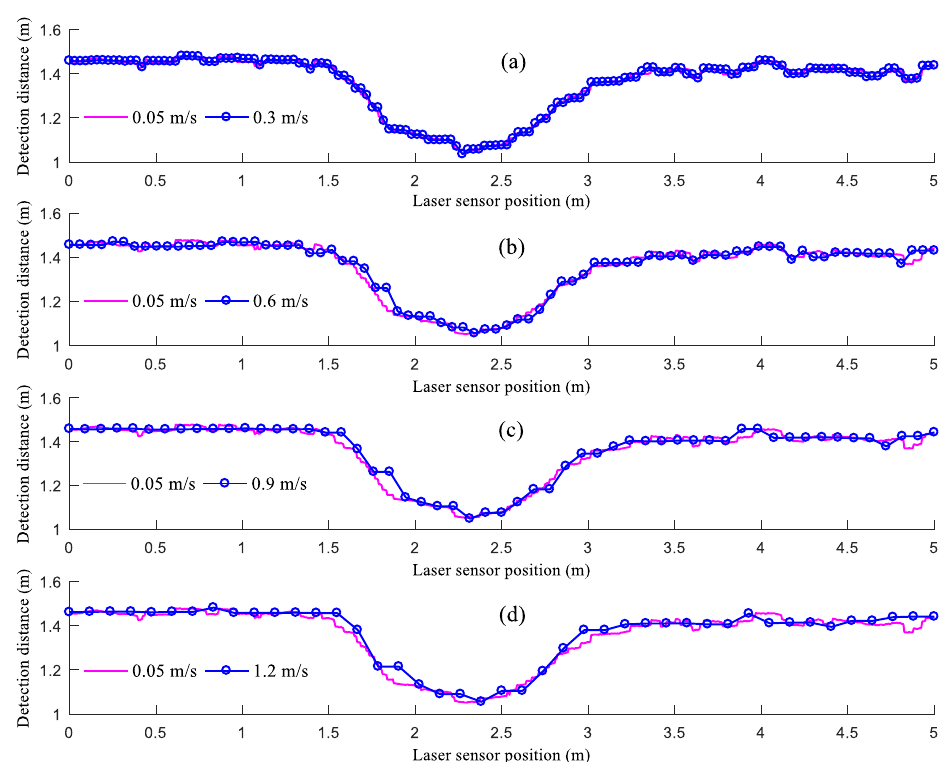
Figure 9. Results of the field ground detection experiment across a speed gradient where: ( a ) 0.3 m/s; ( b ) 0.6 m/s; ( c ) 0.9 m/s; ( d ) 1.2 m/s.